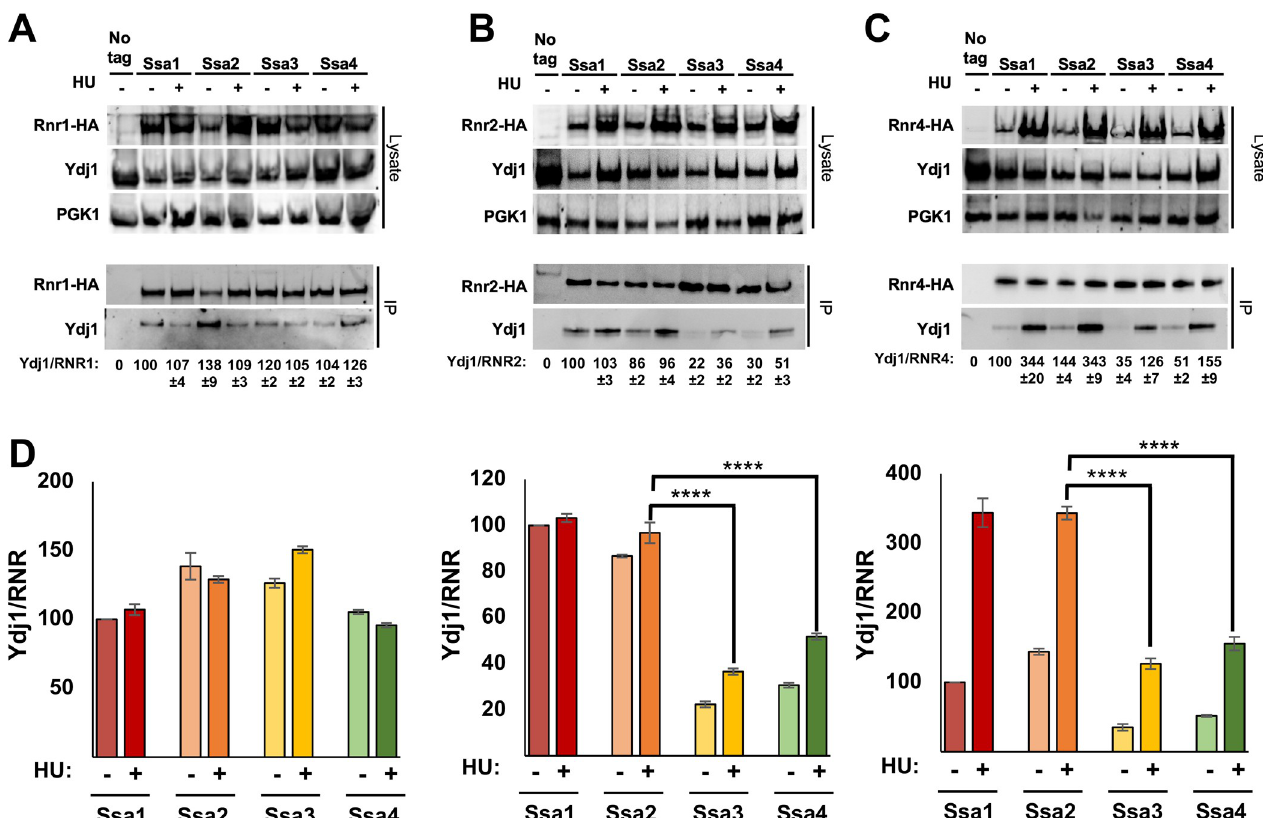
Fig 5. Small RNR subunit interaction with Ydj1 is decreased in Ssa3 and Ssa4 cells. (A-C) Cells expressing either Ssa1, 2, 3 or 4 as their sole Ssa and HA- tagged Rnr1/Rnr2/Rnr4 were grown to exponential phase and were either left untreated or were treated with 200 mM HU for 3 hrs. HA-RNR complexes were immunoprecipitated with anti-HA magnetic beads and were subjected to SDS-PAGE and analyzed by immunoblotting with anti-HA antibodies to detect the RNR subunits or anti-Ydj1 antibodies to detect Ydj1. (D) Interaction between RNR and Ydj1 (Ydj1/RNR) was calculated by quantitating bands from three replicate experiment. Each value represents the mean ± SD (n = 3). Statistical significance between samples was calculated ANOVA. P � 0.05 �� , P � 0.01; ��� , P � 0.001; ���� , P � 0.0001 compared to indicated